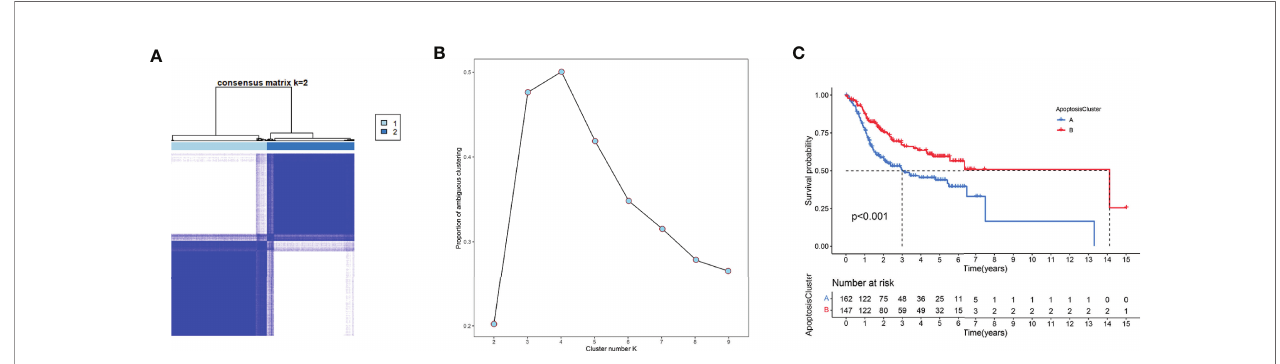
FIGURE 9 | Unsupervised clustering analysis. (A) The clustering heatmap relevant to the consensus matrix for k = 2 acquired by consensus clustering. (B) Corresponding changes in area under proportion of ambiguous cluster curve with k from 2 to 9. (C) K-M analysis demonstrated an obvious survival difference in two apoptosis clusters.